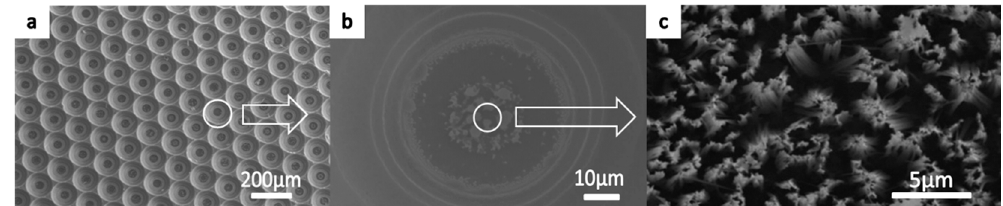
Figure 4. The nanostructures on the micro pits obtained using the wet etching method: ( a ) The top view of the low-magnification micrograph, ( b ) silver on the bottom surface of the pits, and ( c ) the high-magnification SEM image of nanostructures on the bottom surface of the pits.